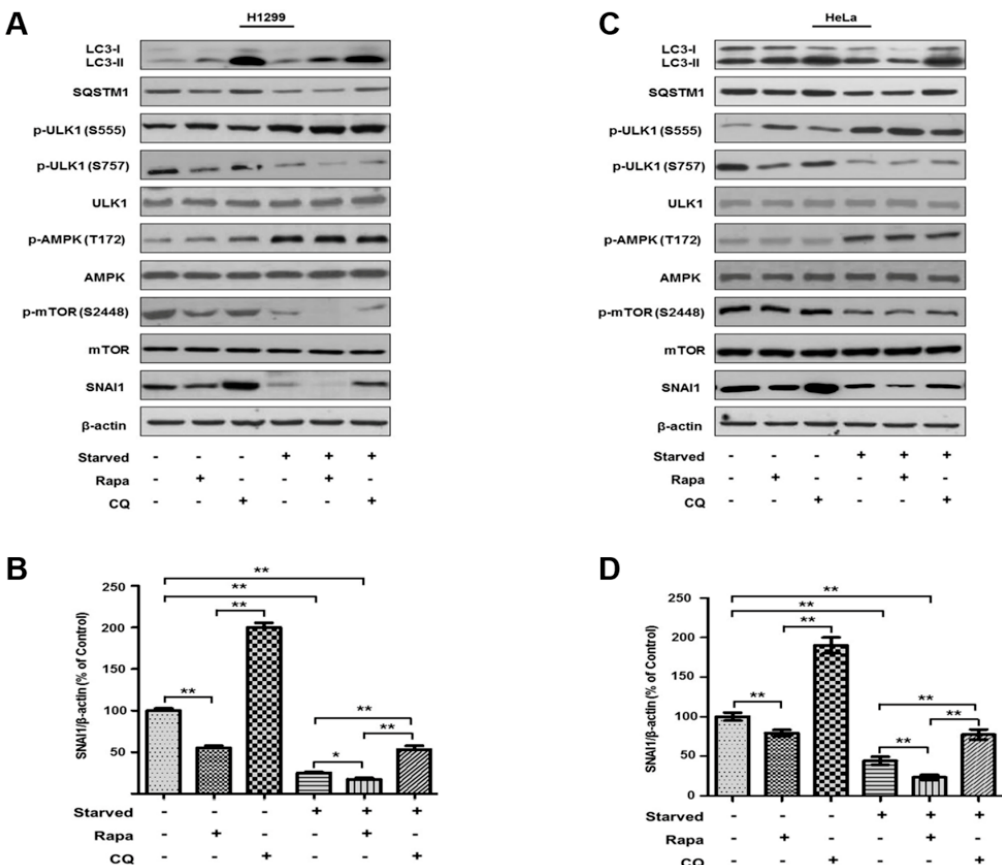
Figure 1. Autophagy stimulates SNAI1 degradation in cancer cells. H1299 ( A ) and HeLa ( C ) cells were treated with 100 nM rapamycin (Rapa) or starved in HBSS medium for 4 h to induce autophagy in the presence or absence of 20 µ M chloroquine (CQ). After lysis, total cell extracts (30 µ g) were separated by 10% or 12% SDS-PAGE and analyzed by western blotting using primary antibodies against LC3, SQSTM1, p-ULK1-S555, p-ULK1-S757, p-AMPK-T172, AMPK, p-mTOR-S2248, mTOR, and SNAI1. β -actin was used as a loading control. The levels of SNAI1 in H1299 ( B ) and HeLa cells ( D ) were quantified using NIH ImageJ software. Data represent the mean ( ± S.D.) of three independent experiments (* p < 0.05 and ** p < 0.01).